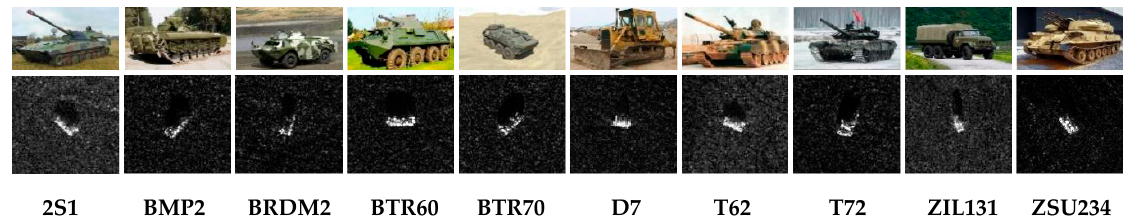
Figure 9. The same type of target in the training set and the test set has the same model number, but their imaging elevation angle and azimuth angle are di ff erent. The training SAR image was collected at 17 pitch angles and the test SAR image was collected at 15 pitch angles, a di ff erence of 2 pitch angles that can be considered negligible. The sample numbers of each target type in the dataset are di ff erent and are listed in Table 2. The initial size of samples is 128 * 128, and then images are cut into size 96 * 96 to reduce the amount of computation.